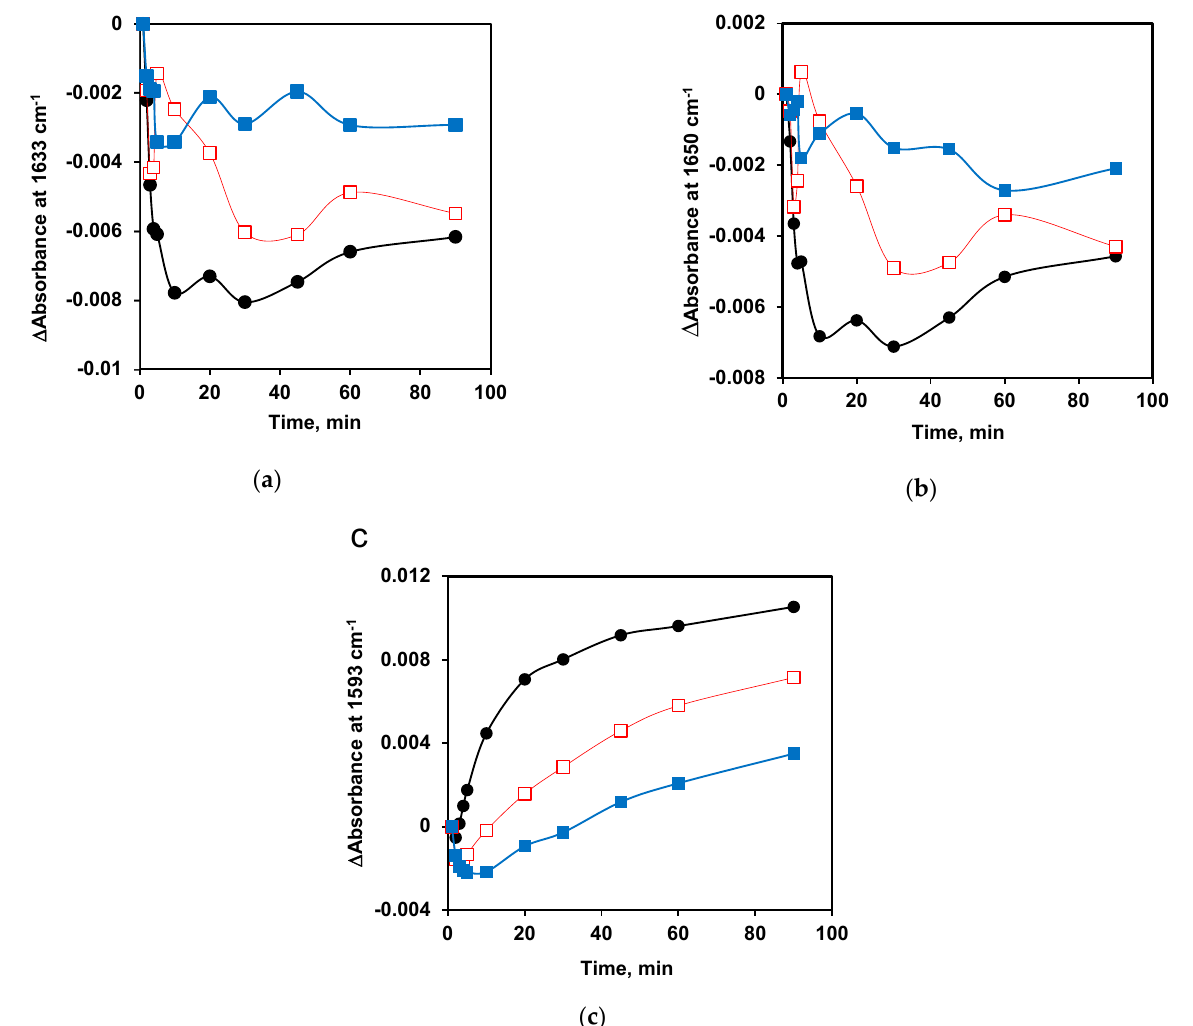
Figure 5. The intensity changes obtained from the FTIR-difference spectra (from Figure 4) with the S 0 / E 0 ratios of 500 ( ● , black), 4000 ( □ , red), and 10,000 ( ■ , blue ) as a function of time during proteolysis reaction. The content of ( a ) β -sheets absorbing at 1633 cm − 1 , ( b ) α -helix absorbing at 1650 cm − 1 , and ( c ) antisymmetric stretching of free carboxylates (proteolysis products) absorbing at 1593 cm − 1 .